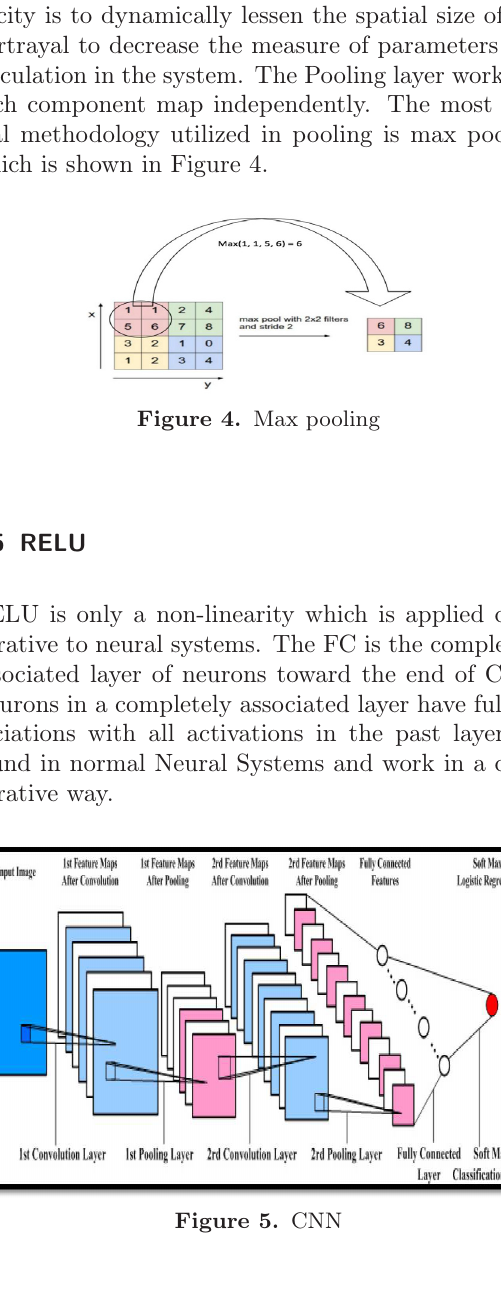
Figure 1. Flowchart of CNN Architecture